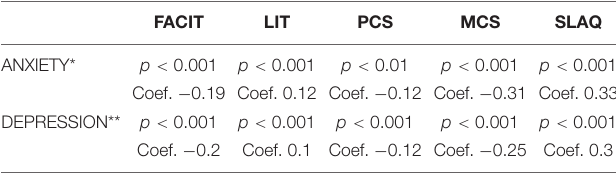
TABLE 4 | Correlation between HADS score and the other PROs: Results of the multivariate analysis. FACIT LIT PCS MCS SLAQ ANXIETY* p < 0.001 p < 0.001 p < 0.01 p < 0.001 p <